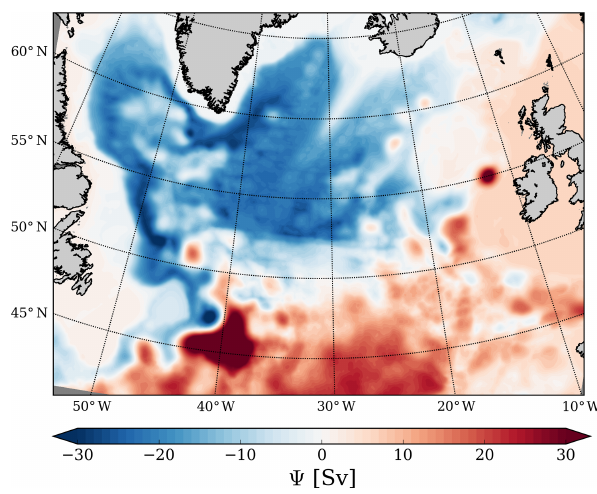
Figure 4. Time-mean barotropic stream function over 2002–2008.